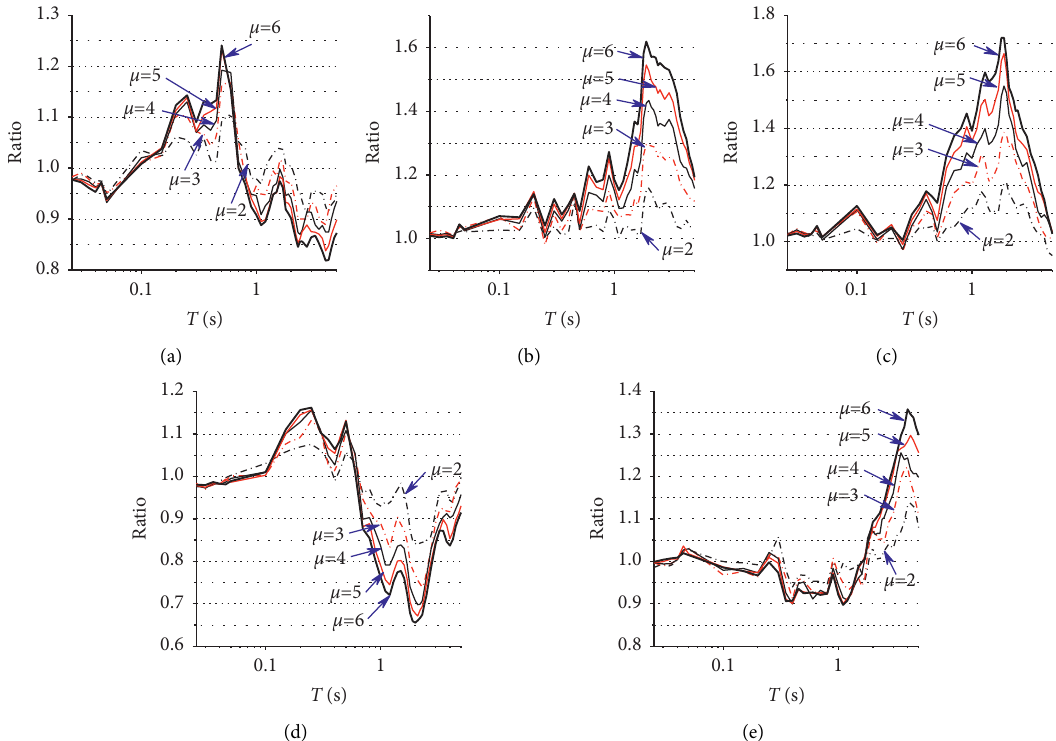
Figure 11: Ratios of the mean inelastic displacement ratios for (a) C μ (PGV > 70 cm/s)/ C μ (PGV ≤ 70cm/s), (b) C μ (PGD > 40cm)/ C μ (PGD ≤ 40m), (c) C μ (PGV/PGA > 0.2s)/ C μ (PGV/PGA ≤ 0.2s), (d) C μ ( I a > 2m/s)/ C μ ( I a ≤ 2m/s), and (e) C μ (Stiff Soil)/ C μ (soft